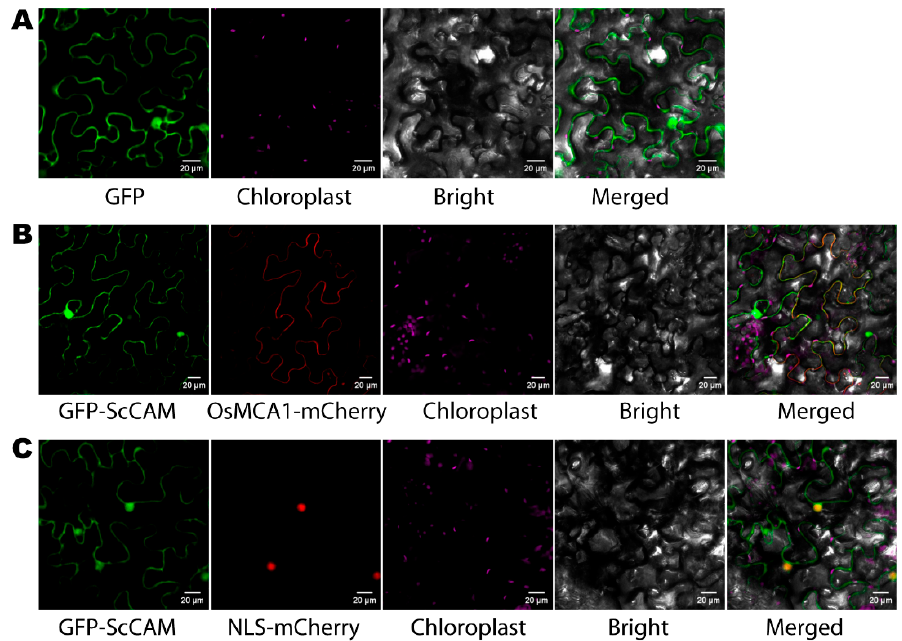
Figure 4. Subcellular localization analysis of ScCaM in Nicotiana benthamiana leaves. ( A ). The subcellular localization analysis of pBWA(V)HS-GFP. ( B ). The subcellular localization analysis of pBWA(V)HS- ScCaM -GFP and OsMCA1-mCherry. ( C ). The subcellular localization analysis of pBWA(V)HS- ScCaM - GFP and